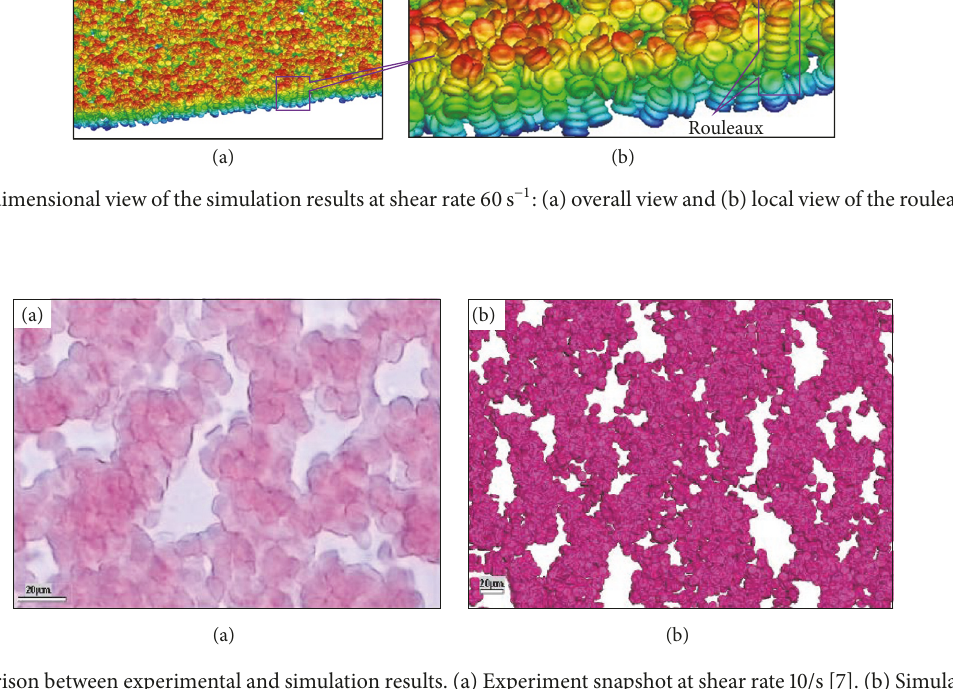
Figure 11: Comparison between experimental and simulation results. (a) Experiment snapshot at shear rate 10/s [7]. (b) Simulation results at shear rate